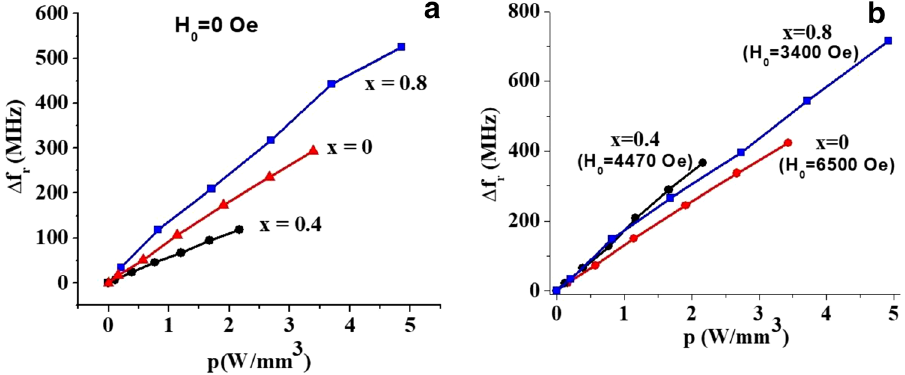
Figure 5. Frequency shift for magnetostatic modes in ( a ) multidomain and ( b ) single domain states as a function of power density under application of electric current for aluminum substituted strontium hexaferrites SrAl x Fe 12−x O 19 for x = 0. 0.4 and